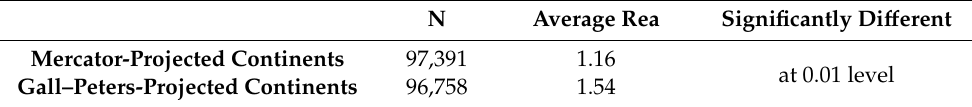
Table 7. Average relative estimated accuracy (rea) values for continents projected with Mercator or Gall–Peters projection.